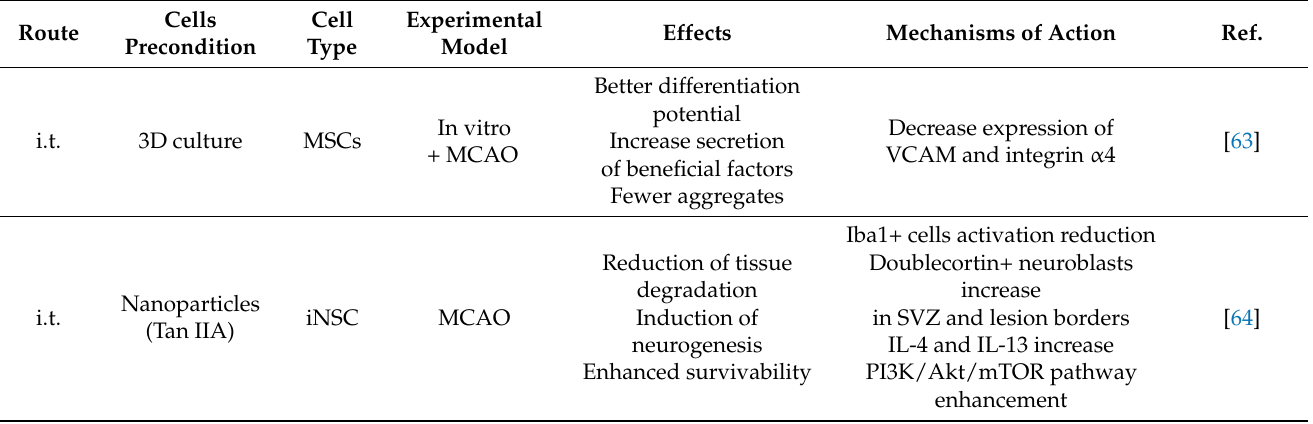
Table 3. Non-classical route of administration and preconditioning strategies in different animal models of